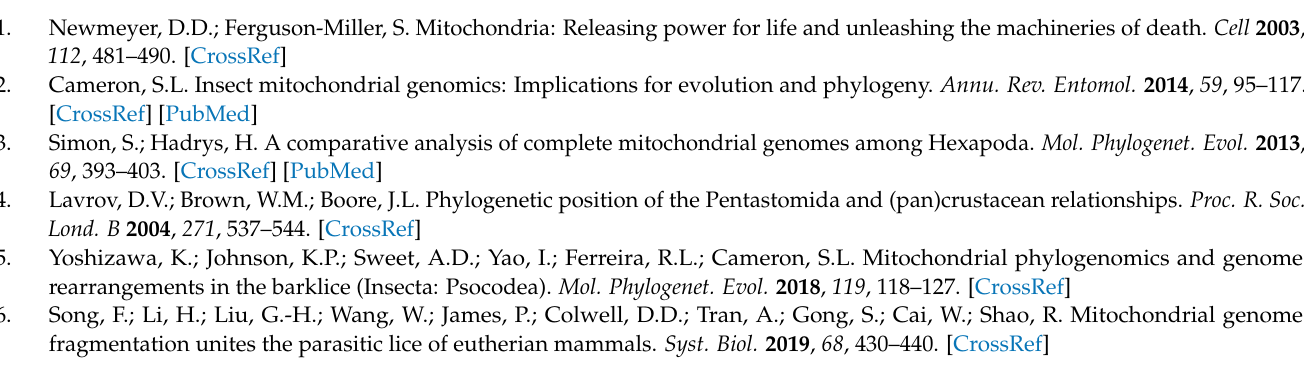
Figure S2: Phylogenetic trees of Reduviidae inferred from Bayesian analyses based on PCGNTRNA and PCGNT12RNA. Posterior probabilities values are labeled around each node, Table S1: The NCBI accession numbers of mitogenomes used to calculate the Ka/Ks ratios, Table S2: The NCBI accession numbers of sequences used in phylogenetic analyses, Table S3: The partitioning schemes and models used for phylogenetic analyses, Table S4: Codon usage pattern of Ptilocnemus lemur and Ischnobaenella hainana mitogenomes, Table S5: The NCBI accession numbers of true bugs mitogenomes with gene